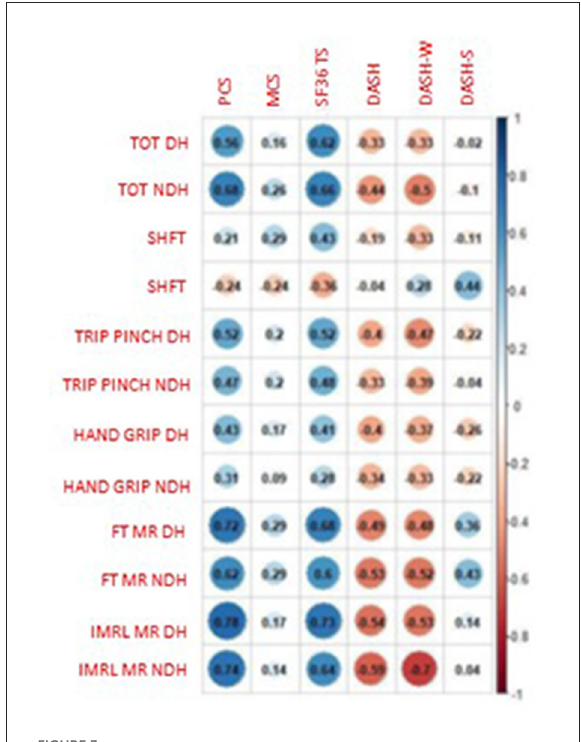
FIGURE3 Correlations between clinical and instrumental Oms and Qol. PCS, physical composite score; MCS, mental composite score; TS, total score; DASH, Disability of Arm, Shoulder and Hand; DASH-W, DASH work; DASH-S, DASH sport; TOT, Thumb opposition test; SHFT, Sollerman hand function test; Trip pinch, tripod pinch; FTMR, finger tapping movement rate; IMRL MR, Index, medium, ring, little movement rate; DH, dominant hand; NDH, non-dominant hand.